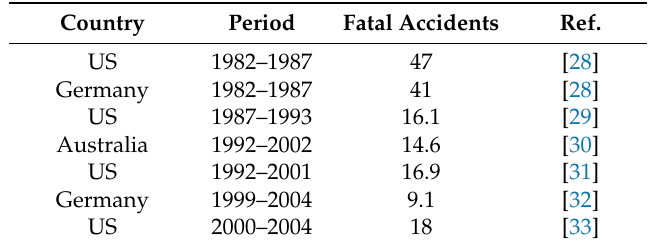
Table 1. Fatal Crash Rate Helicopter EMS (per million flight hours) [27]. Country Period Fatal Accidents